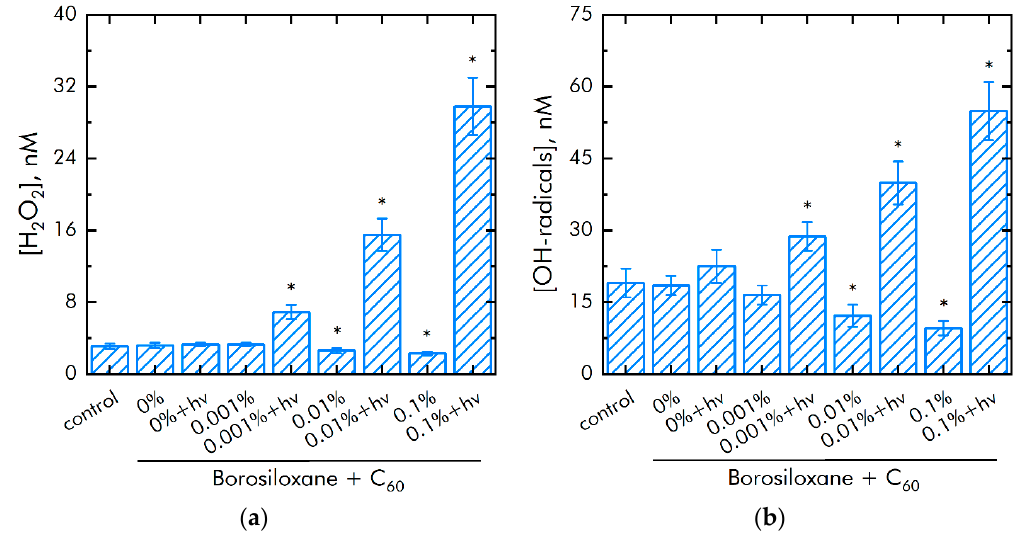
Figure 7. Effect of composite material containing borosiloxane and fullerenes on the generation of reactive oxygen species: ( a ) Formation of hydrogen peroxide (2 h, 40 °C); ( b ) Generation of hydroxyl radicals (2 h, 80 °C); * indicate a significant difference at 5% level in comparison with the control ( p <0.05). Data are presented as mean values and standard errors.